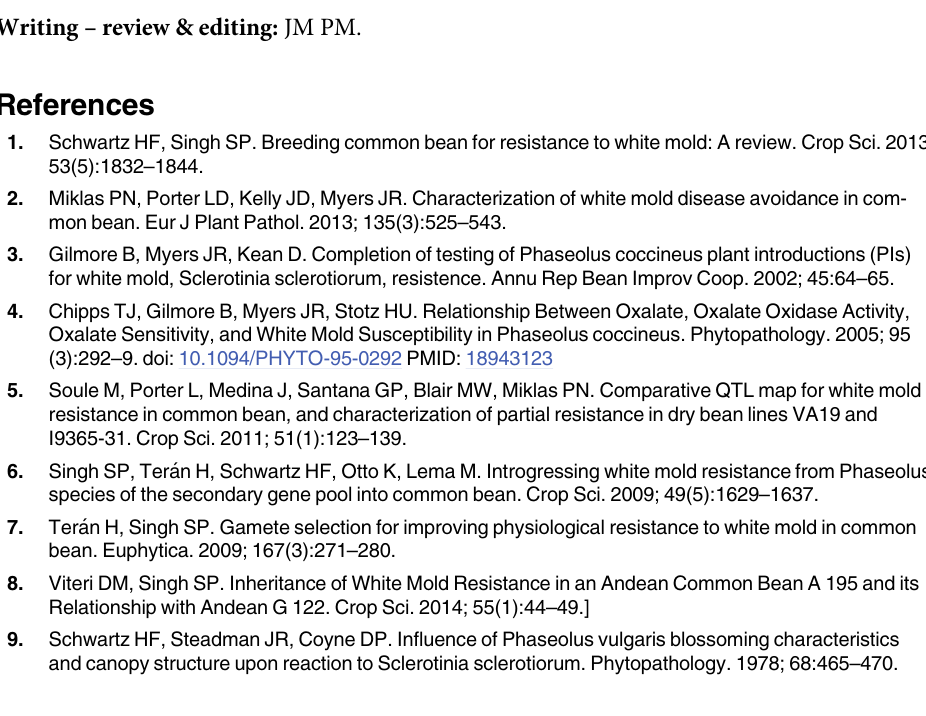
M: O12, Fig N: AN, Fig O: M25, Fig P: U25, Fig Q: R31, Fig R: GW populations. The highlighted markers represent cofactors. Horizontal solid line represents significance thresh- old of P < 0.05% based on 1000 permutations for the trait with the lowest LOD value. S1 Table. SNPs that define the start, peak, and end position of white mold meta-QTL in common